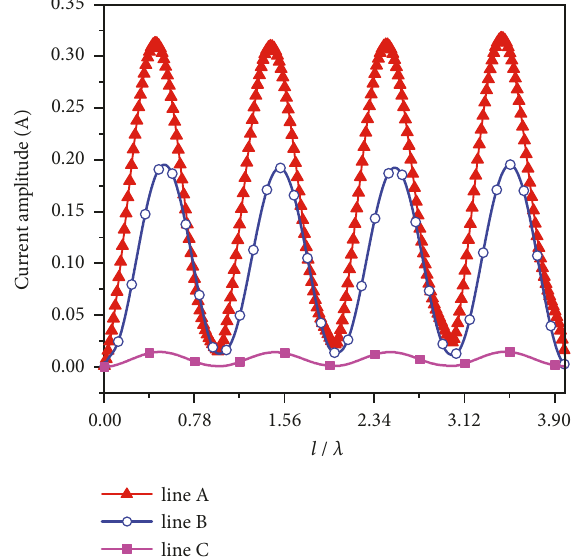
Figure 14: Currents induced on the power lines. The radii are 0.007 m, and the lengths are 20 m.